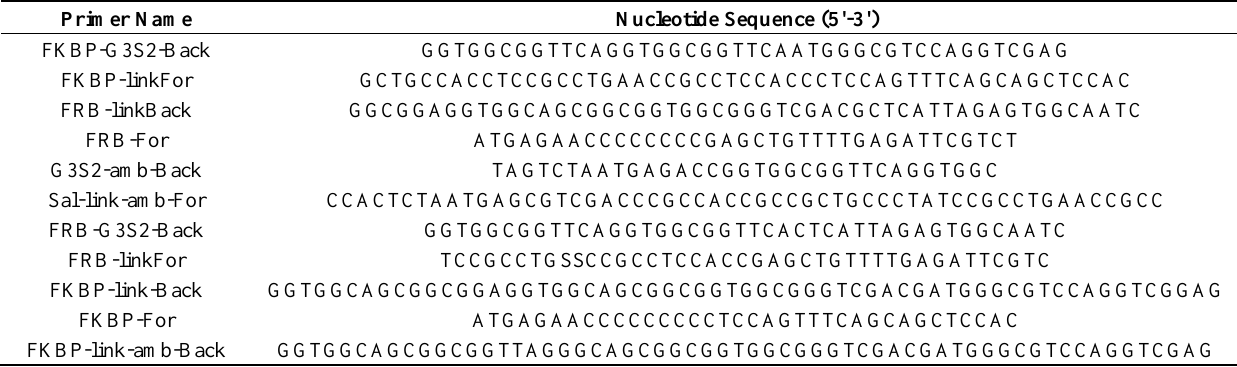
Table 1. Nucleotide sequences of primers used in this